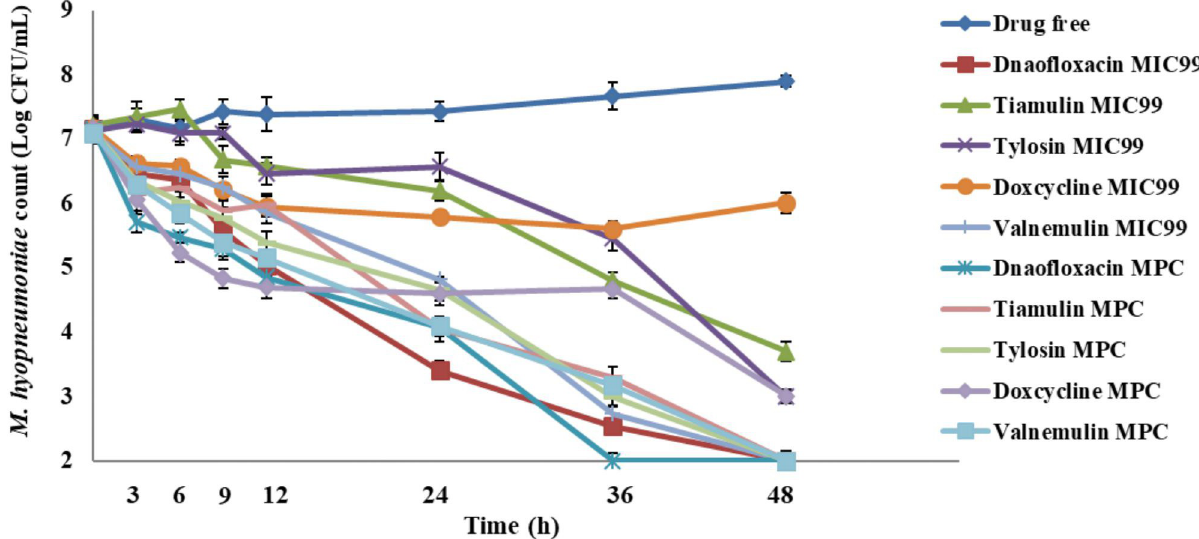
Fig 3. M . hyopneumoniae killing curves at the minimal concentration inhibiting colony formation by 99% (MIC 99 ) and at the mutant prevention concentration (MPC) with an inoculum of 10 7 CFU/mL. https://doi.org/10.1371/journal.pone.0220350.g003 2.5 or 10 mg/kg (body weight); after oral administration at a dose of 20 mg/kg, C values for max danofloxacin, tylosin, and doxycycline were 0.45 ± 0.09, 2.71 ± 1.09, and 2.44 ± 0.51 μ g/mL [28–30] . Correlative MIC and MPC values were 0.101 and 1.0, 0.34 and 10.24, and 0.343 and 99 4.0 μ g/mL, respectively. The reported tiamulin and valnemulin concentrations were comfort- ably above the MSW values only after oral administration at a dose of 10 or 25 mg/kg [31, 32] .